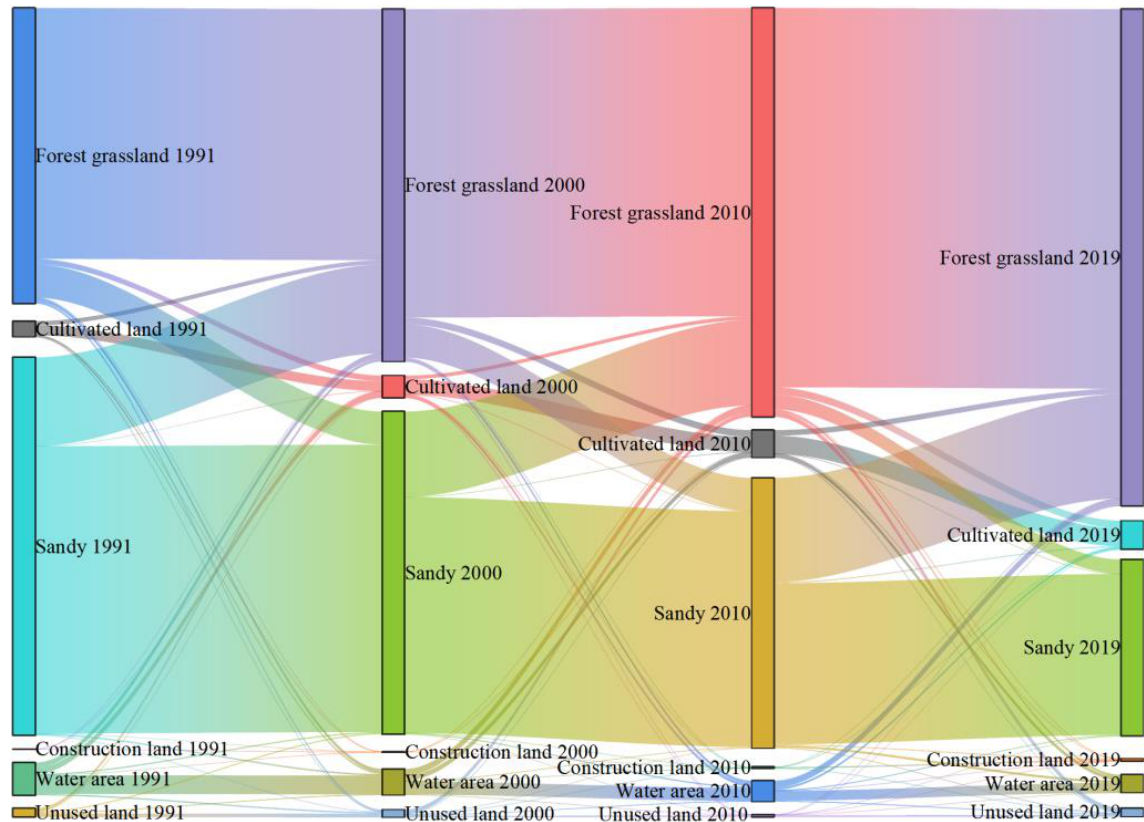
Figure 5. Land-use transfer in various periods along the Yellow River section of the Hobq Desert.